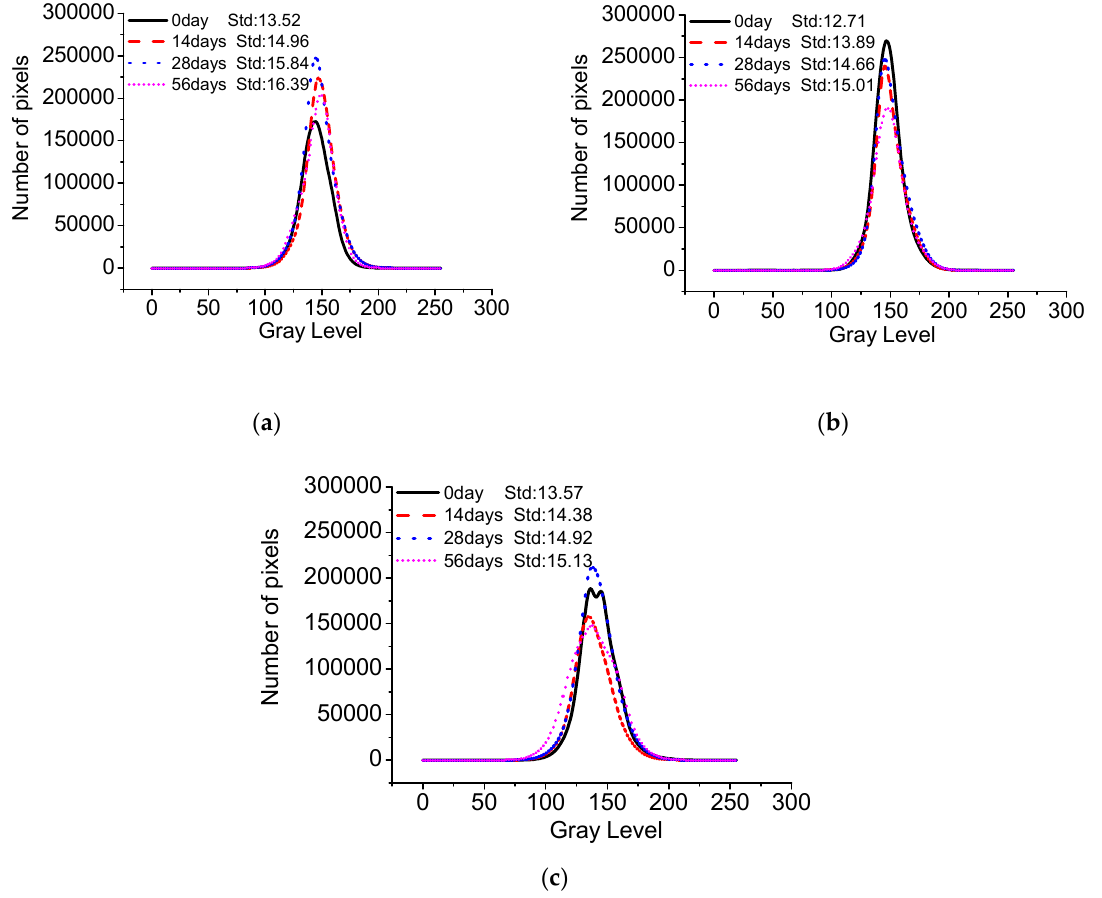
Figure 15. Gray of C40, C50, and C55 exposed to carbonation environment after different exposure times. ( a ) C40. ( b ) C50. ( c ) C55.